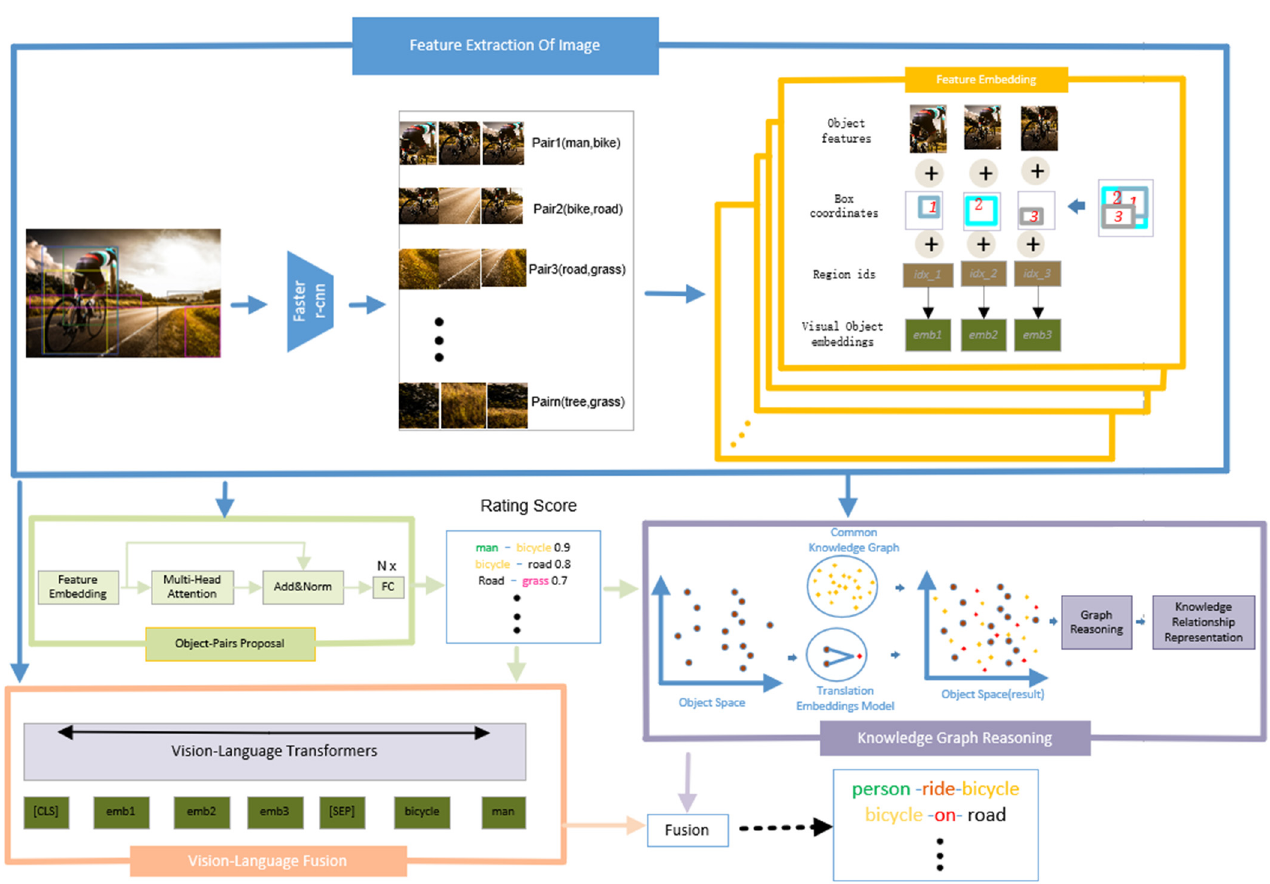
Figure 2. Structure of our proposed framework. A blue box is a module that is used to extract the features of an image and predict object labels. The green box can propose object-pairs and rate location embedding. The orange and brown boxes are the vision–language fusion module and knowledge graph reasoning module, respectively.